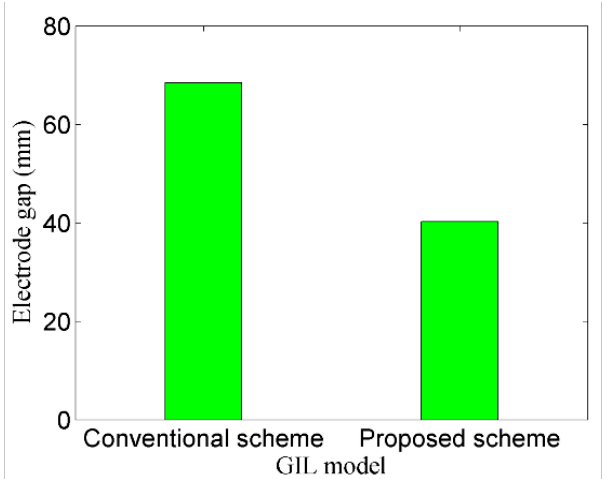
Figure 13. Electrode gap comparison between conventional and proposed flexible GIL (FGIL) schemes.